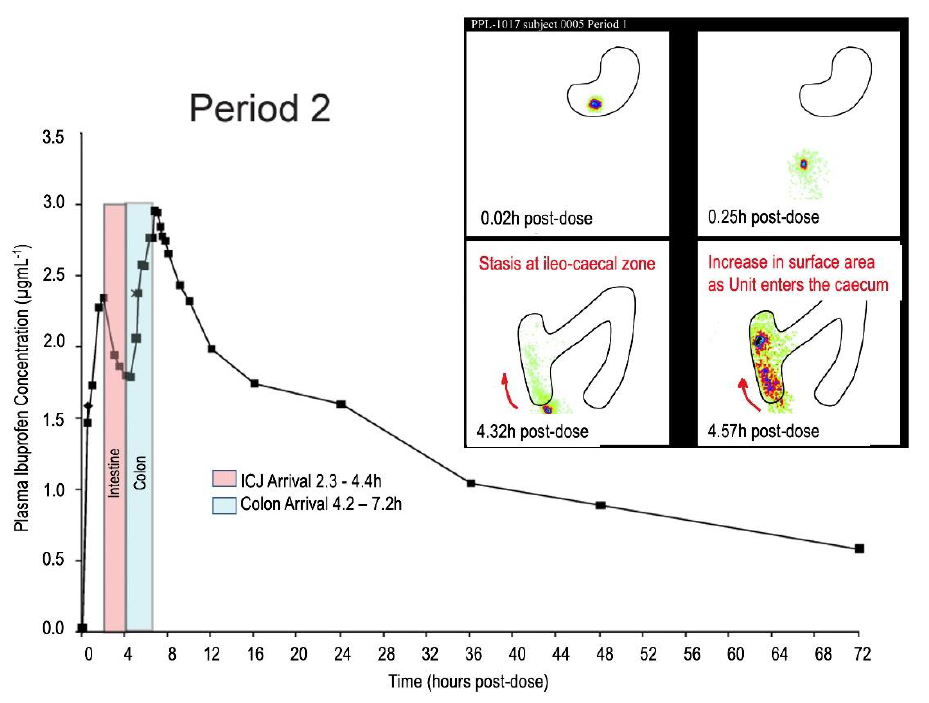
Figure 1. PK of an ibuprofen preparation in the cecum overlaid with intestinal and colonic localization. Colon arrival was associated with the second peak of drug concentration (ICJ: ileocecal junction) Based on International Journal of Pharmaceutics , 50, Wilson et al., “Bimodal release of ibuprofen in a sustained-release formulation: a scintigraphic and pharmacokinetic open study in healthy volunteers under different conditions of food intake”, 155– 161. [19]. Copyright Elsevier (1989).